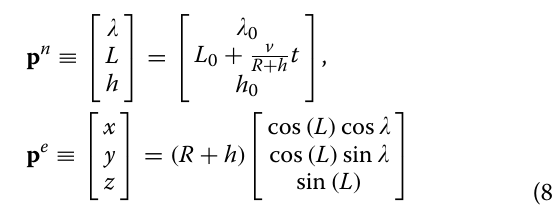
(cid:31) = 120 ◦ , L = 50 ◦ 0 0 and = 2000 m/s. According to Eqs. (3)